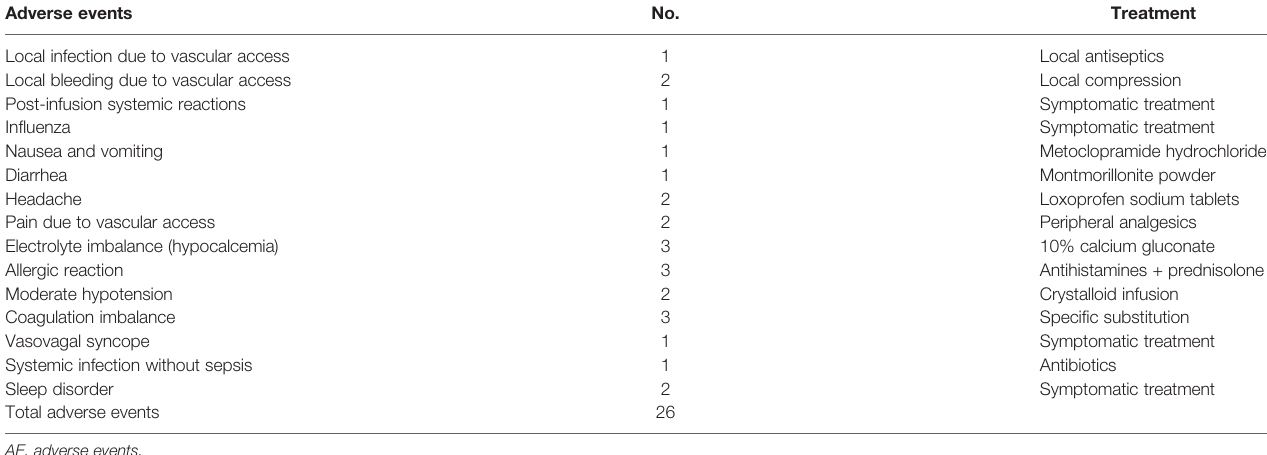
AE, adverse events.